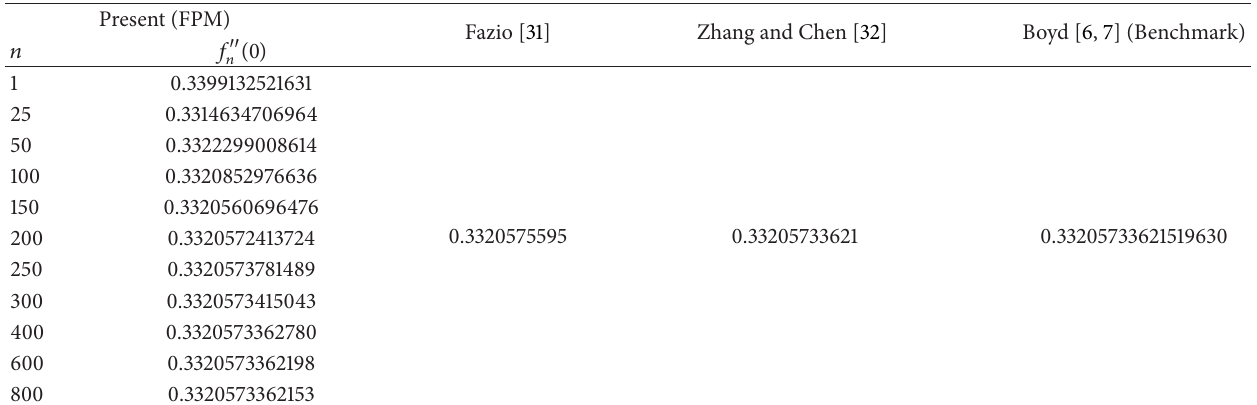
Table 1: Comparison of 𝑓 󸀠󸀠 (0) between FPM ( 𝜆 = 1/5 ) and